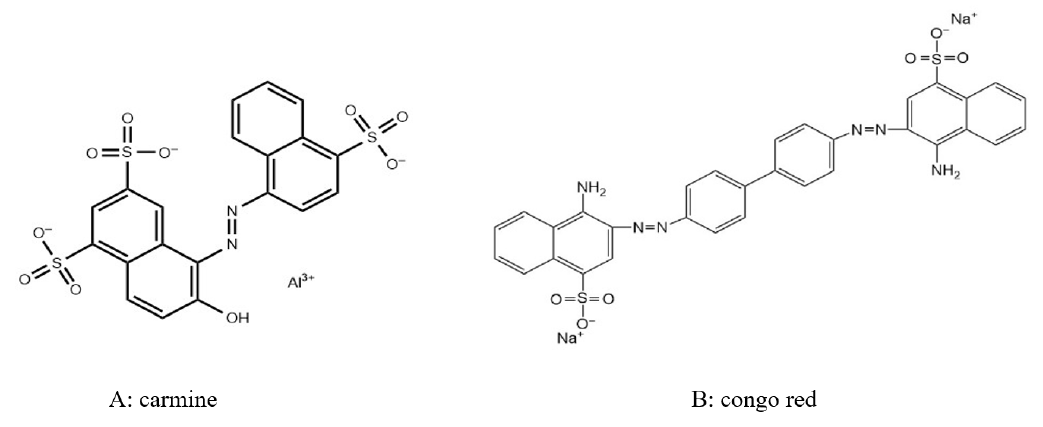
Figure 2. Structure of carmine (A) and Congo red (B). Table 1. Chemical properties of carmine and Congo red.